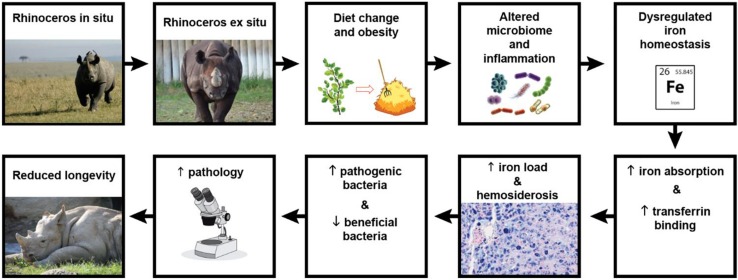
Schematic of the study’s suggested hypothetical model. When black rhinoceroses are captured, their diet changes from browse to hay, altering their natural microbiome and subsequent nutrient absorption. Additionally, the high nutrient diet and lack of exercise lead to over conditioning, obesity, inflammation, and metabolic disturbance which results in dysregulated iron homeostasis. Transferrin binding sites become saturated with iron which is also increasingly stored in organ tissues (hemosiderosis). Microbial competition in an iron-rich environment alters gut colonization in favor of pathogenic lineages, while more beneficial populations decrease. The resulting microbial and metabolic disturbances lead to greater disease susceptibility, health syndromes and pathologies, ultimately reducing the population’s median longevity. (Photo credits following the flow of the diagram: Renee Fulconis, Cincinnati Zoo & Botanical Garden; Hailee Butler, Cincinnati Zoo & Botanical Garden.)